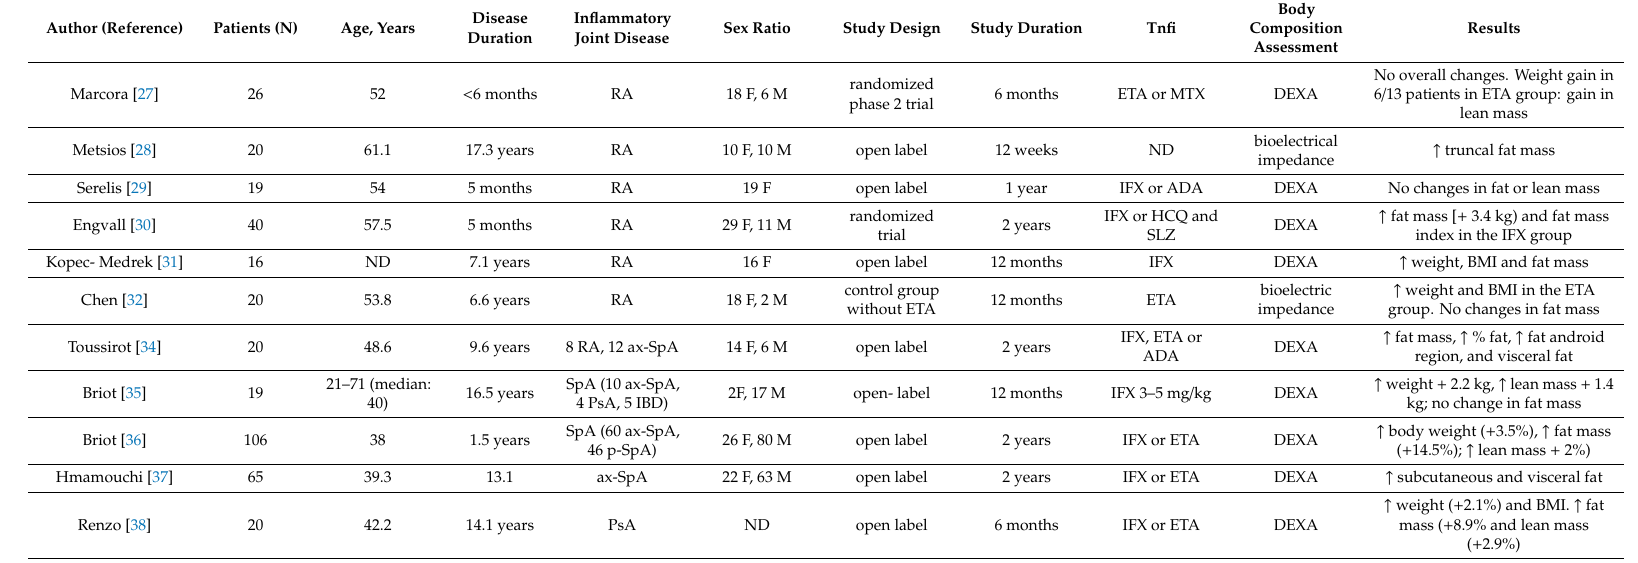
Table 1. Changes in body composition during Tumour necrosis factor (TNF) inhibitor treatment in inflammatory rheumatic diseases.